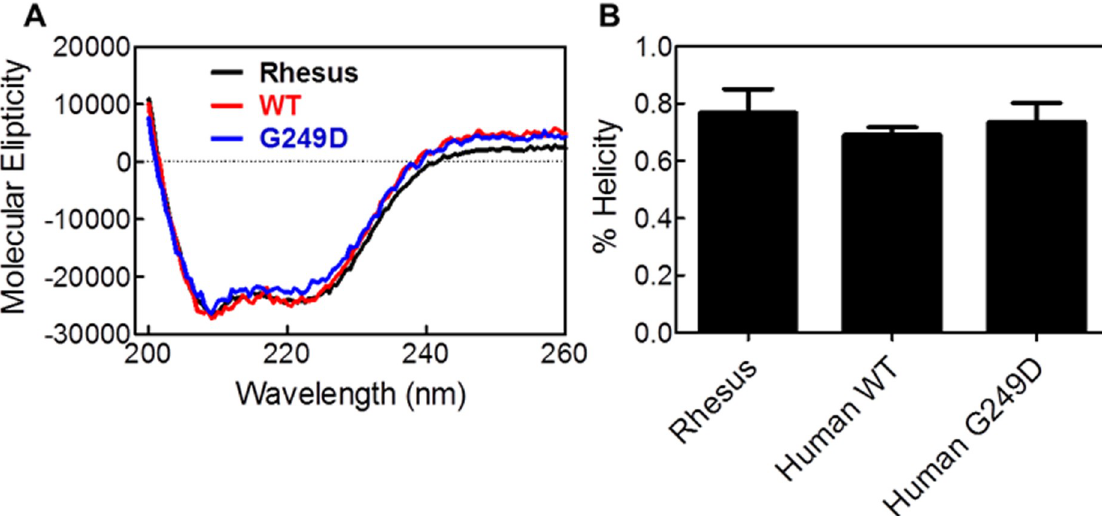
Fig 2. G249D polymorphism in human Trim5 α does not affect α -helical content. (A) Circular dichroism of purified CC-L2 peptides of rhesus (in black), human WT (in red) and G249D (in green) TRIM5 α given in molecular elipticity units. (B) Helical content is calculated by using Selcon II software. Error bars represent SEM of 4 biological